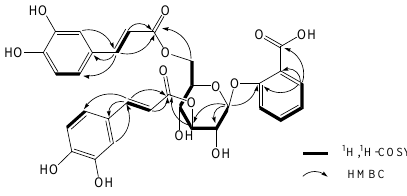
Figure 3. Key HMBC and COSY correlations of compound 1